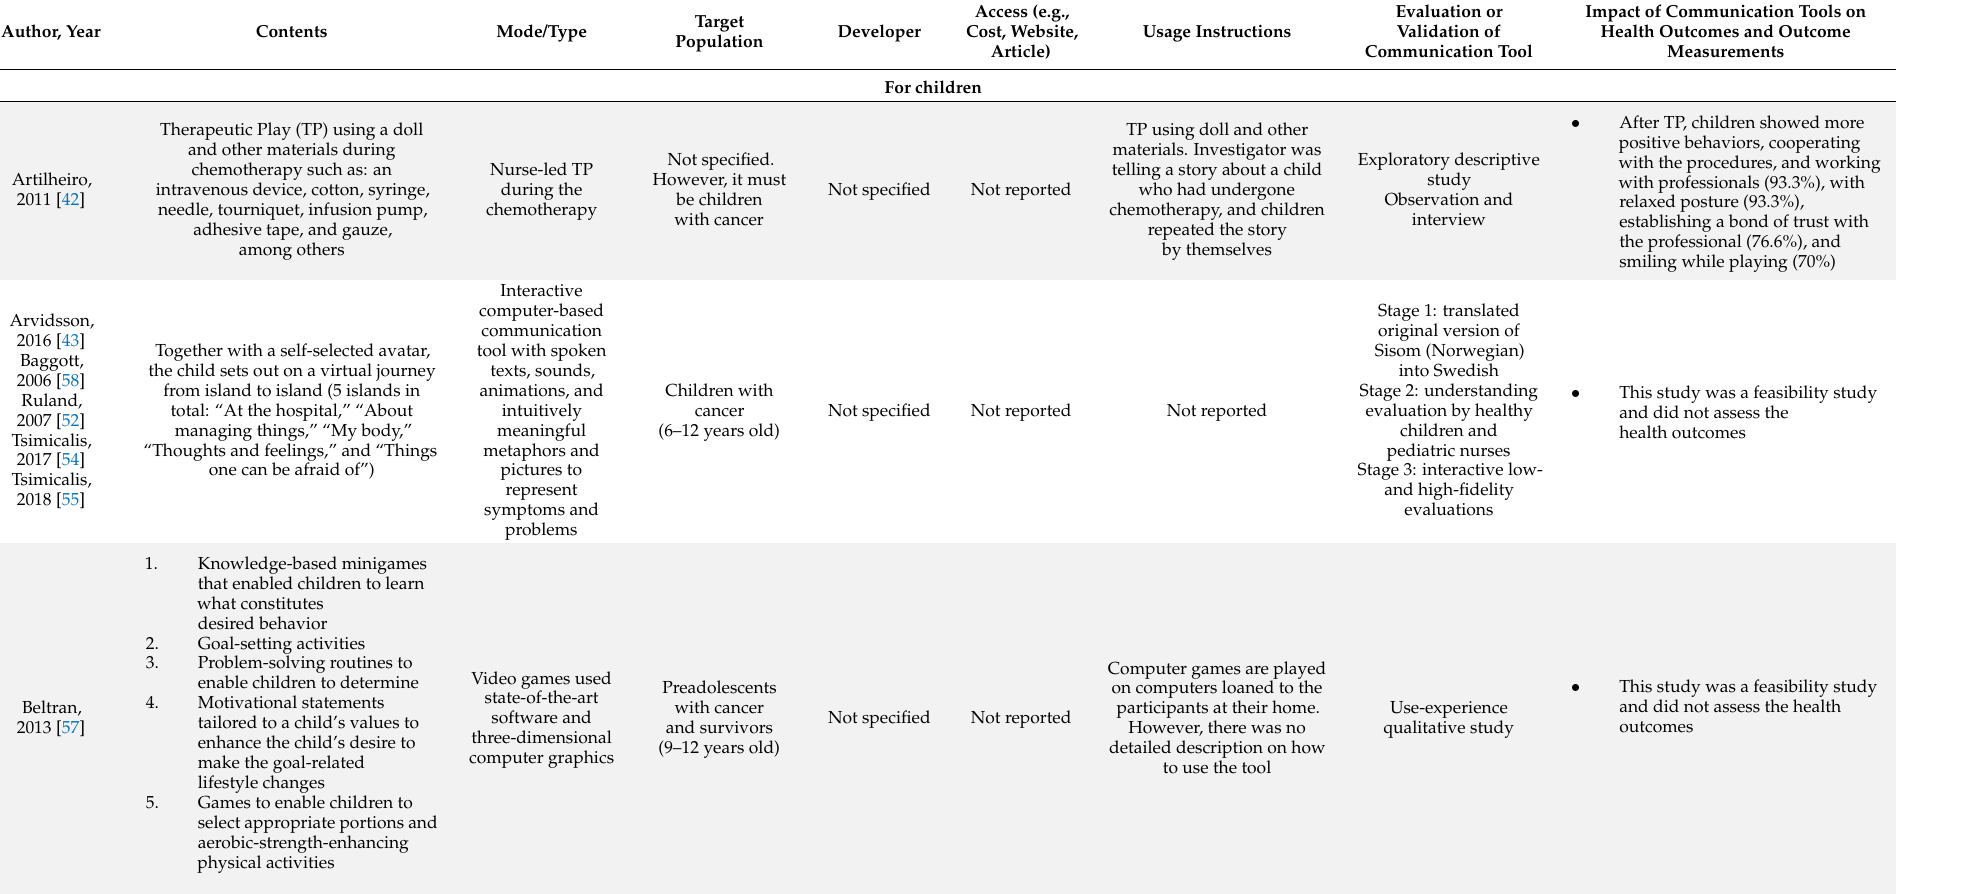
Table 2. Characteristics of communication